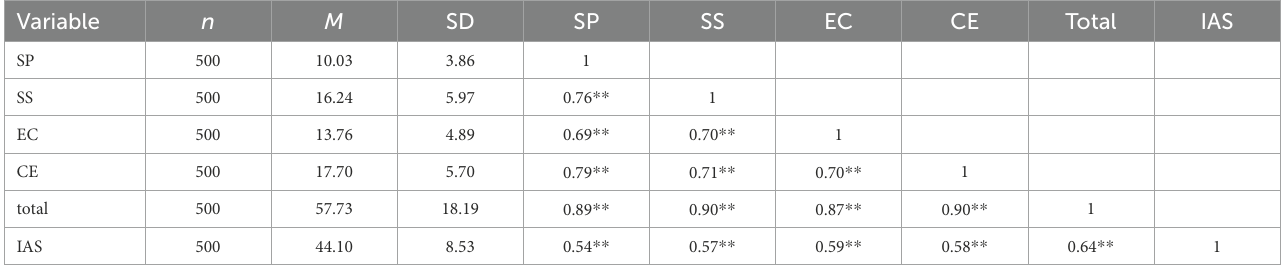
TABLE 5 Correlation matrix between SACS-CS and IAS.